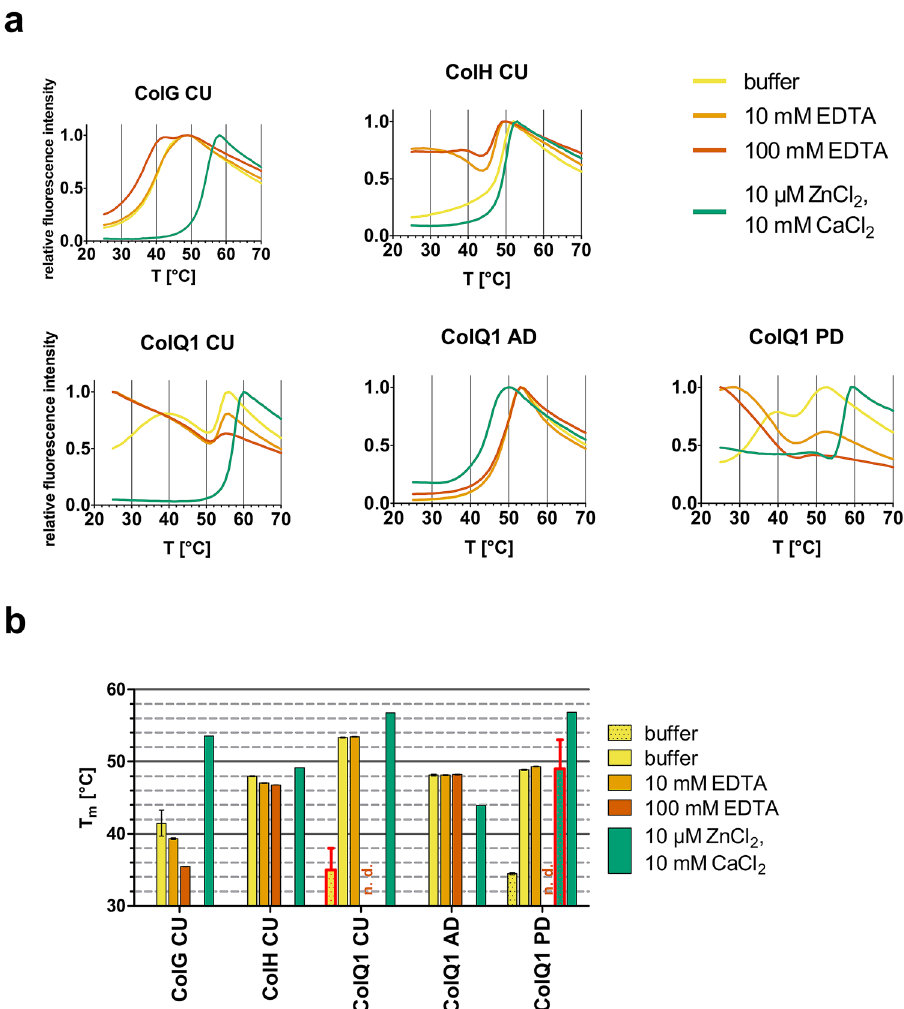
Figure 3. Differential scanning fluorimetry (DSF) of collagenase units of ColG, ColH and ColQ1 and activator and peptidase domains of ColQ1. ( a ) Representative melting curves in 20 mM HEPES, 80 mM NaCl, pH 7.5, 5 × SYPRO orange dye without further additives (yellow), with 10 mM EDTA added (orange), with 100 mM EDTA added (dark orange) and with 10 µM ZnCl 2 and 10 mM CaCl 2 added (green). ( b ) Melting temperatures determined from the DSF curves by Boltzmann fitting. n. d.: no melting temperature determination possible. In case of ColQ1 CU & PD the dotted and unfilled buffer bars are the two distinct first melting temperatures seen in ( a ). The melting temperatures that could not be determined numerically, but only graphically, are highlighted by bold red borders. Data are shown as mean ± SD (n =